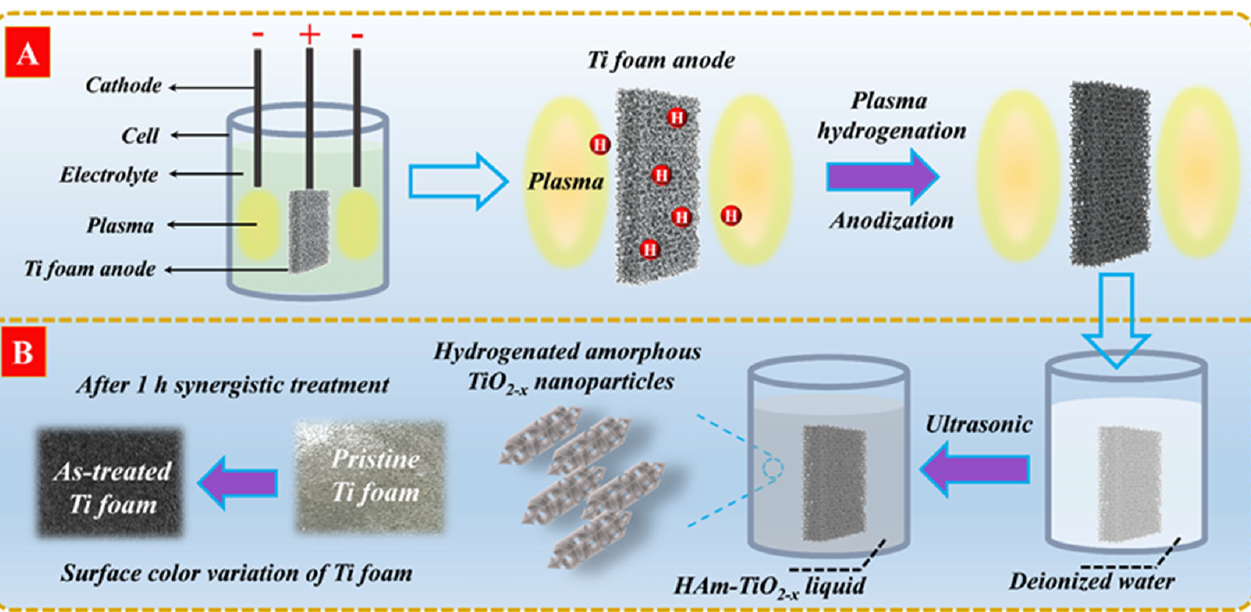
Figure 1. ( A ) Synthesis setup of producing HAm-TiO 2 − x , and ( B ) the generation process of HAm- TiO 2 − x nanoparticles.